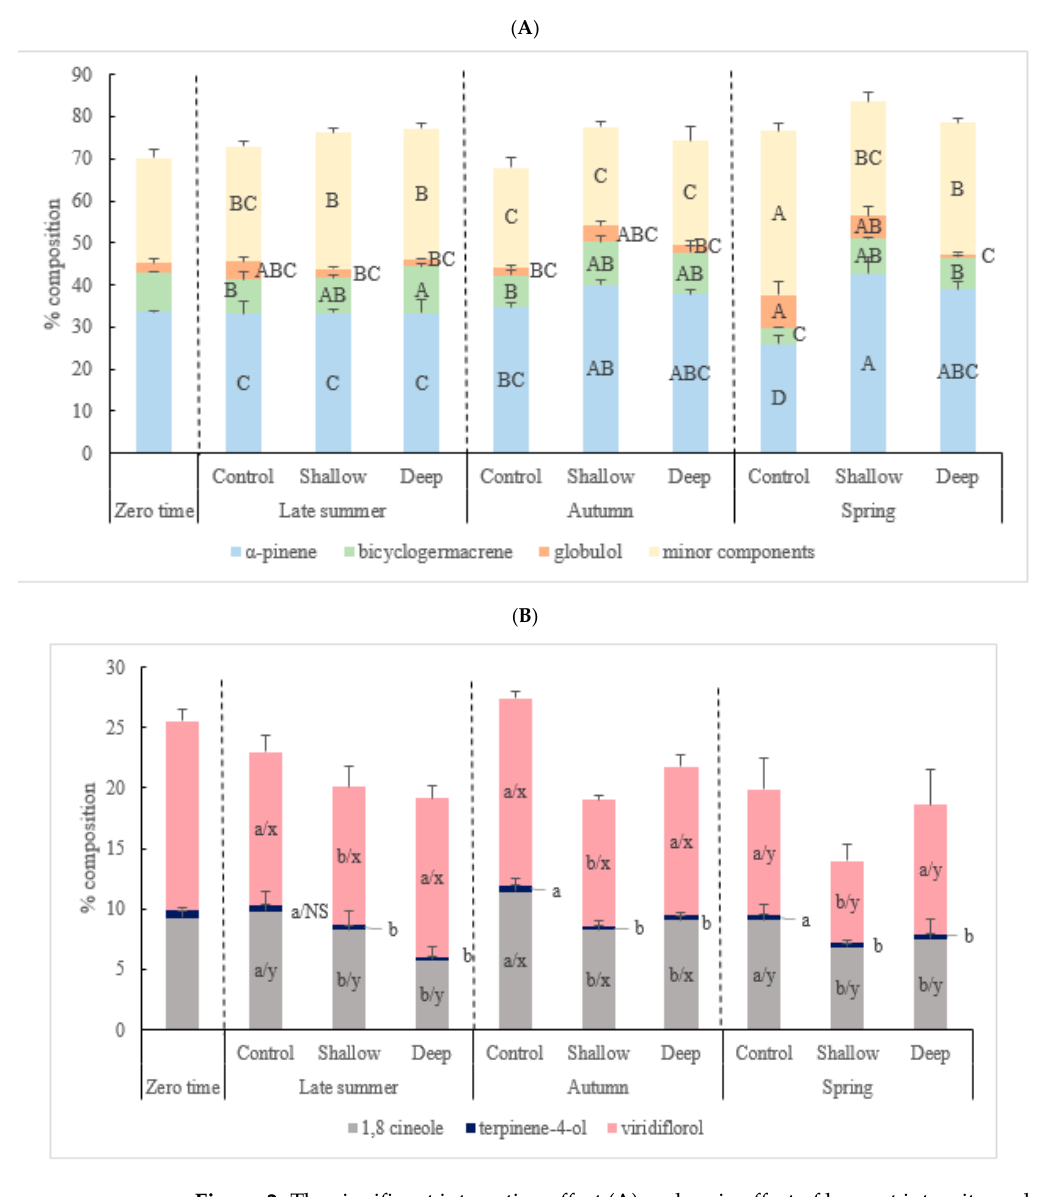
Figure 2. The significant interaction effect ( A ) and main effect of harvest intensity and season, respectively, ( B ) on the major chemical constituents (%) in kunzea oil. Values are presented as means ± SD (n = 4). Mean values designated by a different letter are significantly different between groups according to two-way ANOVA test with initial harvest intensity (HI) and season (S) as variability factors: initial harvest intensity (HI) for a, b, c and season (S) for x, y, and z using lowercase letters, and initial harvest intensity (HI) × season (S) interaction for capital letters. The zero-time data was not included in two-way ANOVA test. NS: not significant.